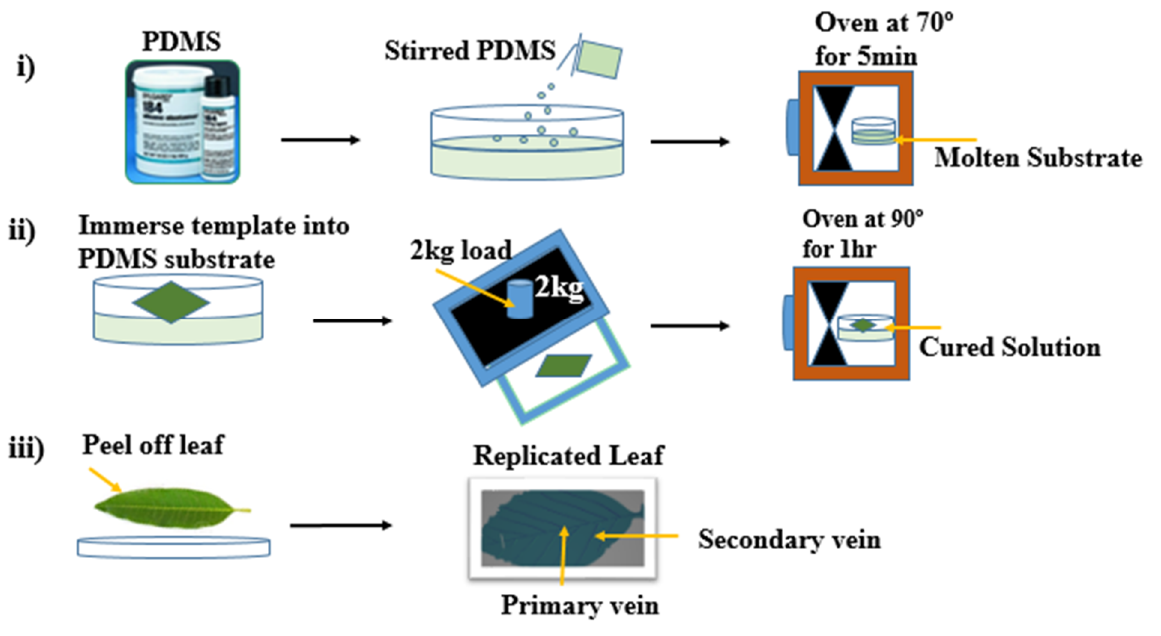
Figure 2. Soft lithography process for replication of plant leaf substrates using PDMS ( i ) Molten substrate preparation ( ii ) Template immersion into the molten substrate and ( iii ) Final replication stage.